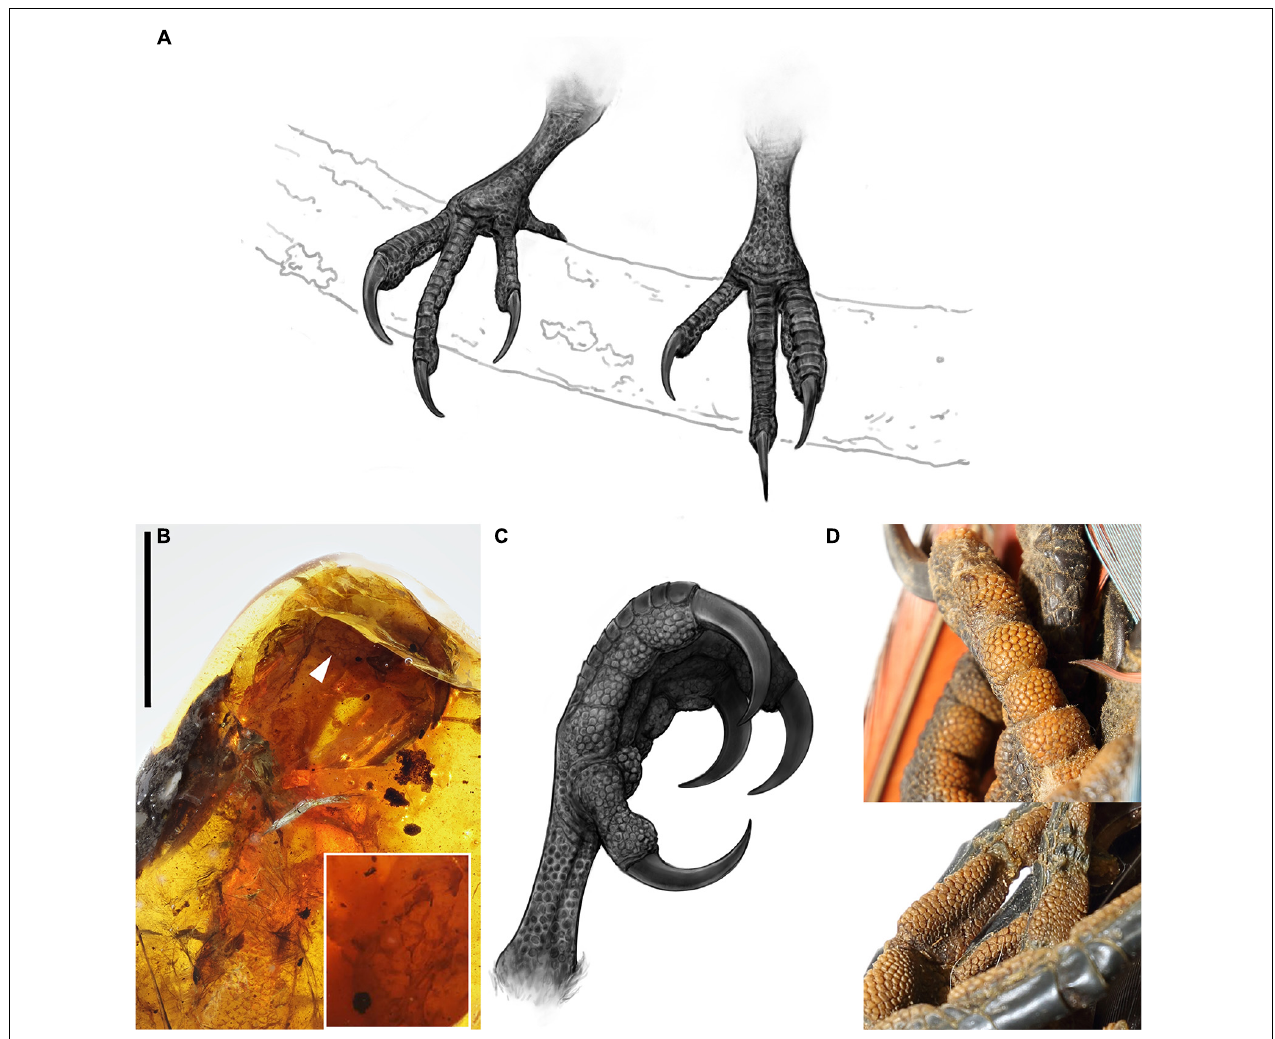
FIGURE 4 | (A) An in-life reconstruction of Fortipesavis prehendens ’ pedes. The most robust digit is laterally placed on each pes and the plantar pads exhibit a slight pebbly texture. (B) The amber mold of Fortipesavis prehendens in medial view, with focus on the reticulae textured plantar pads of digit II. Inset shows larger image of plantar pad texture as signaled by the white arrow. Scale bar = 5 mm. Photo of specimen YLSNHM01001 credited to Lida Xing, used with permission from Jingmai O’Connor. (C) In-life reconstruction exhibiting the same posture as the amber specimen, exhibiting the textured plantar pads similar to the texture seen in other extant avian pedes (D) such as members of the Psittacidae ( Ara chloropterus ) (top) and Ramphastidae ( Rhampastos toco )